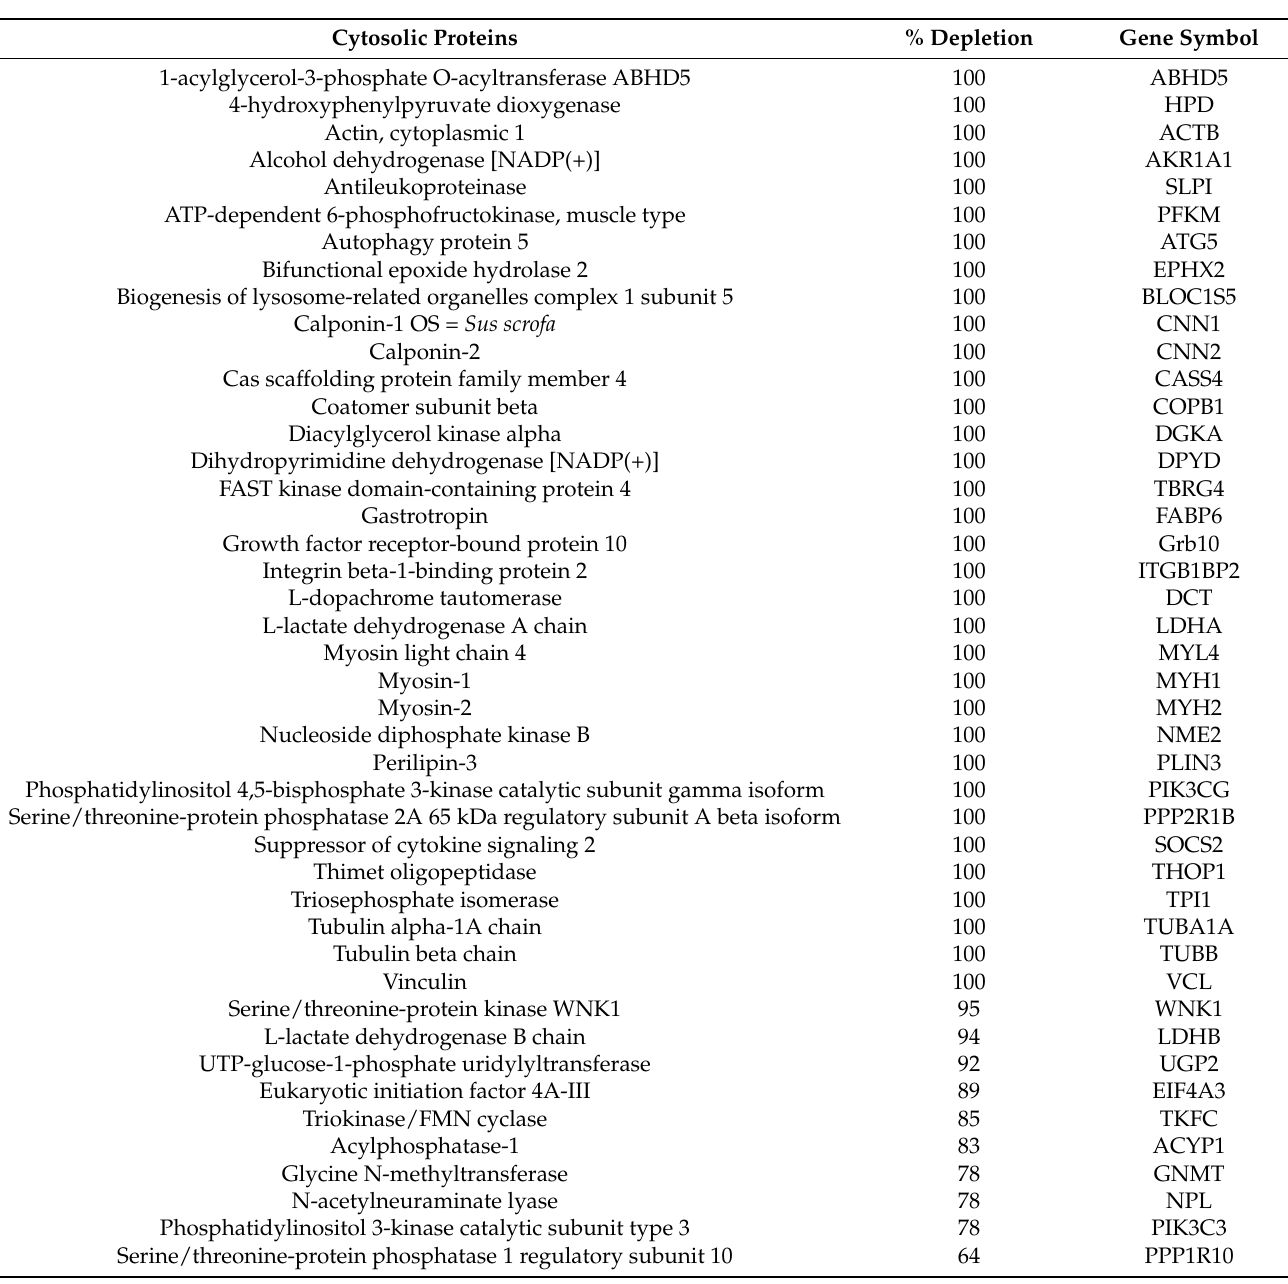
Table A3. Cytosolic proteins depleted during